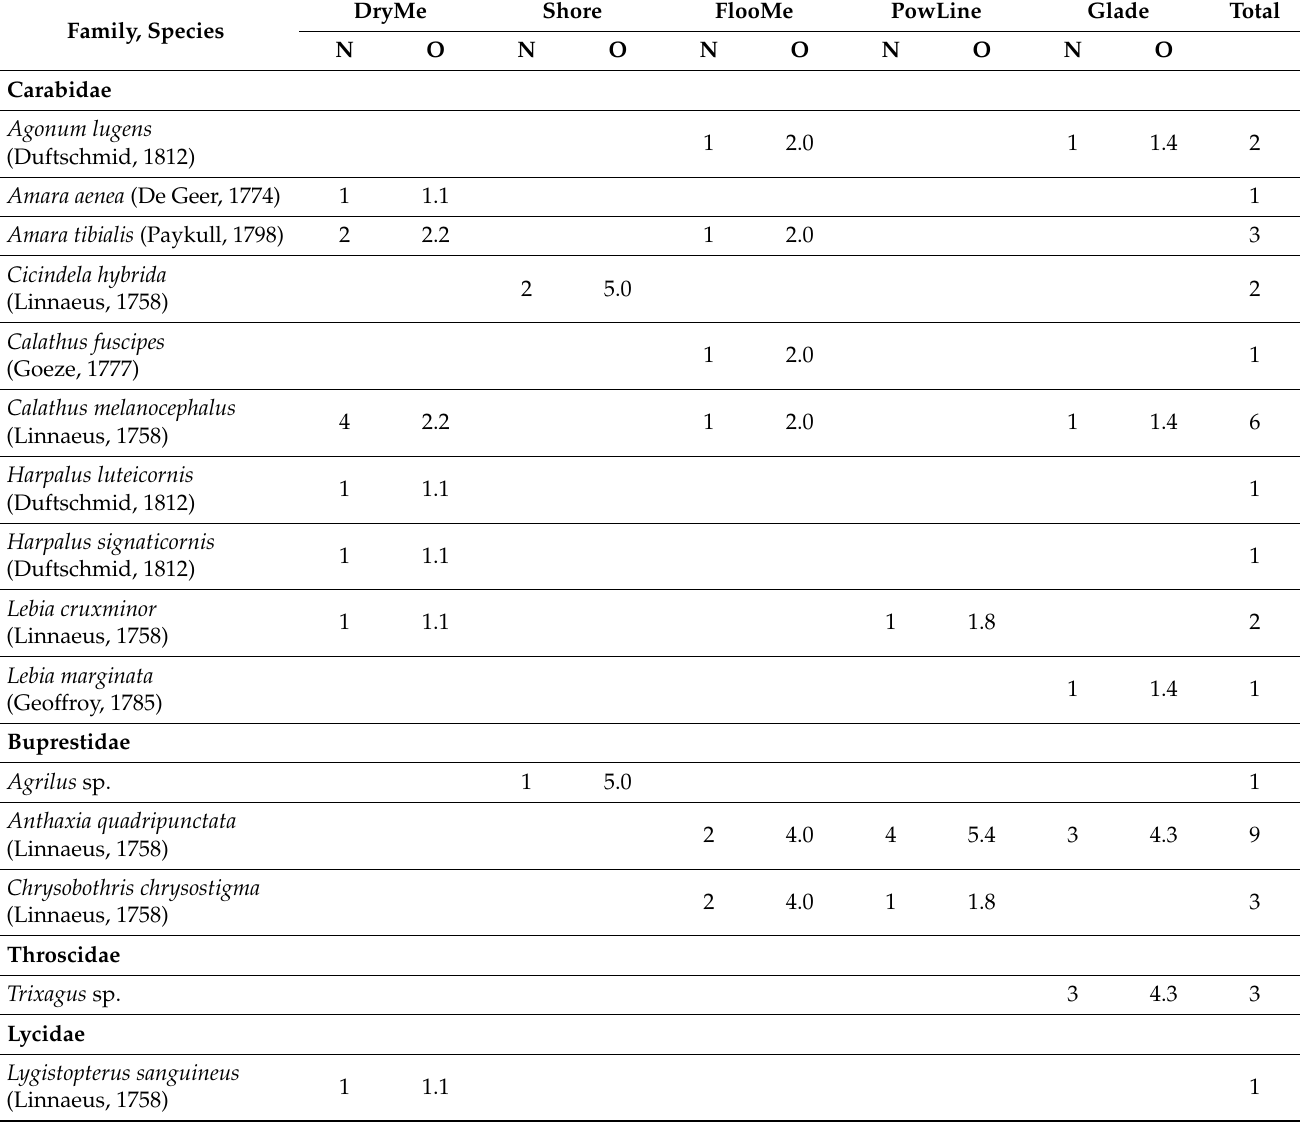
Table A1. Biodiversity and occurrence of Coleoptera from fermental traps in the European part of Russia (N—Number of specimens, O—occurrence,